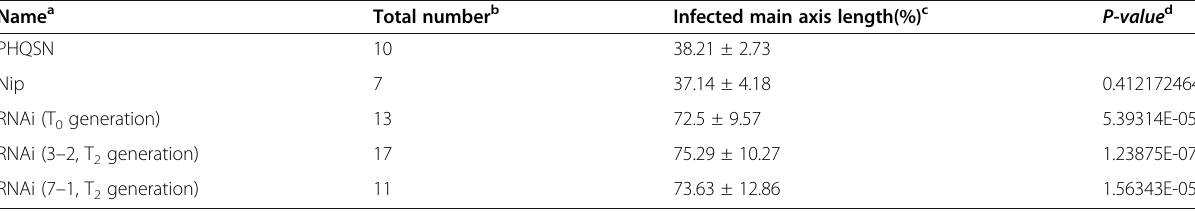
Table 2 The infected main axis length of control (PHQSN) and OXO silencing plants after inoculation Name